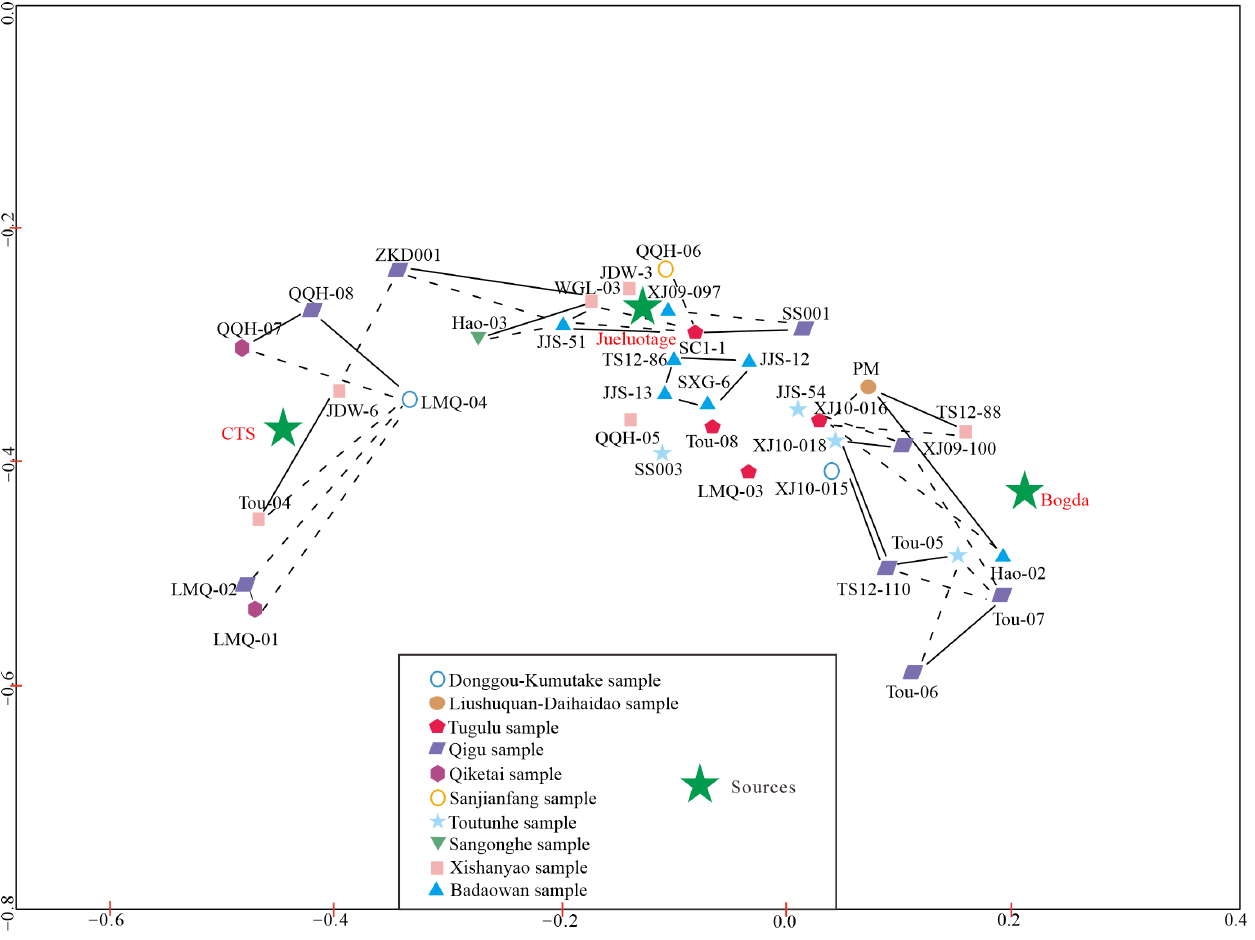
Figure 7. Multidimensional scaling (MDS) diagram of the study samples (data from [23–26,33,35,43,63–65,68,74,103] and this study).